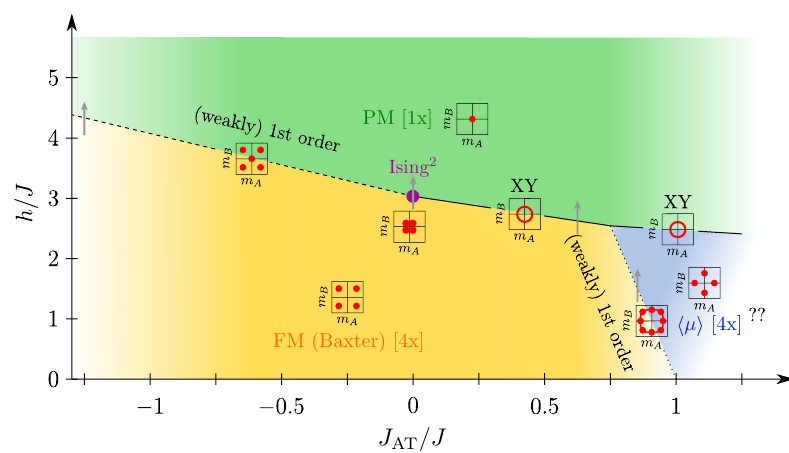
Figure 2: Sketch of the phase diagram for the AT-TFI model, Eq. (2). Full lines de- note continuous phase transitions, dashed lines (weakly) first order transitions. The histograms sketch the typical sublattice magnetization histograms P ( m corresponding phases and at the phase transitions. The magenta point denotes the Ising 2 critical point, XY denotes criticality in the 3D XY / O(2) universality class. The question marks indicate regions we have not investigated in detail. The gray arrows indicate the paths through the phase transitions shown in Fig. 3. The ground state degeneracy of the phases is given by the numbers in square